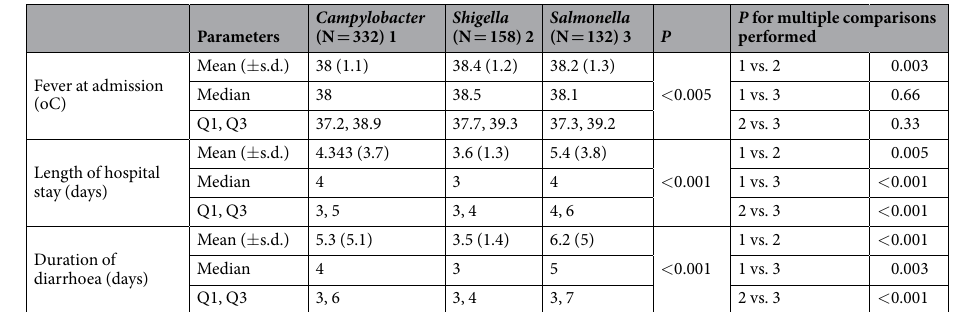
Table 2. Fever, and length of hospitalization and diarrhoea duration.